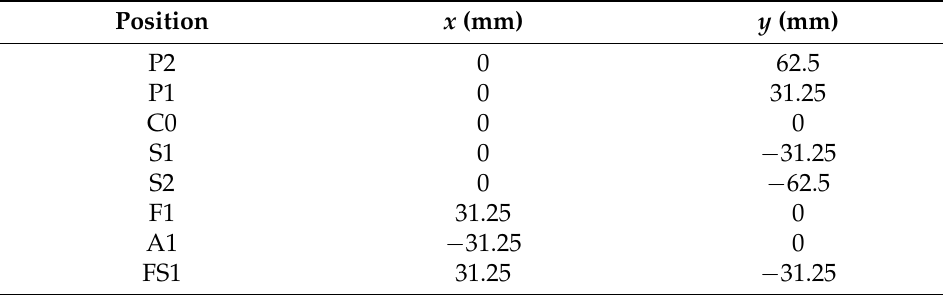
Figure 5. Position of the hydrophones at the hull surface (projected). Table 1. Coordinates of the hydrophones at the hull surface